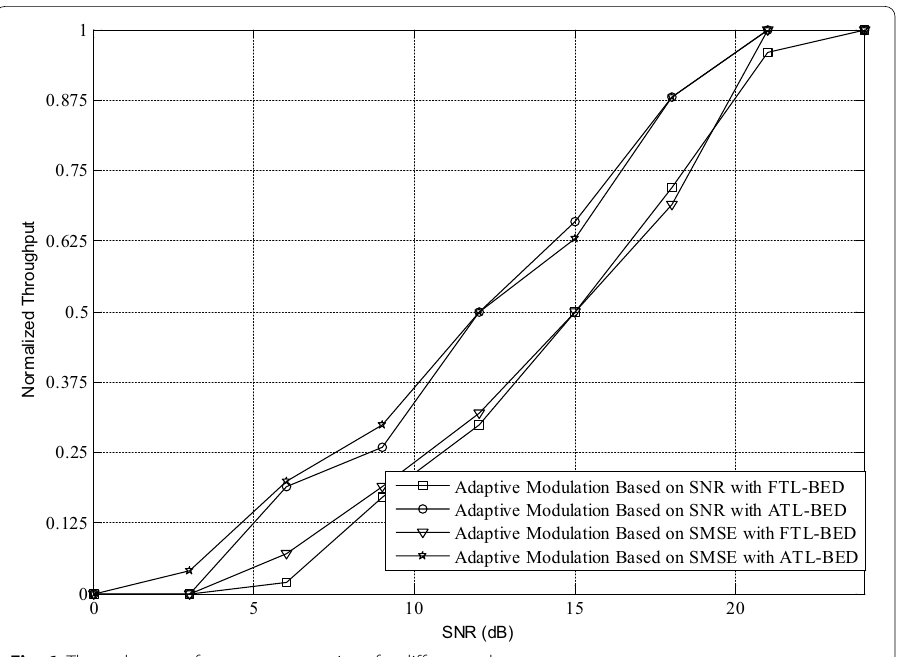
Fig. 6 Throughput performance comparison for different